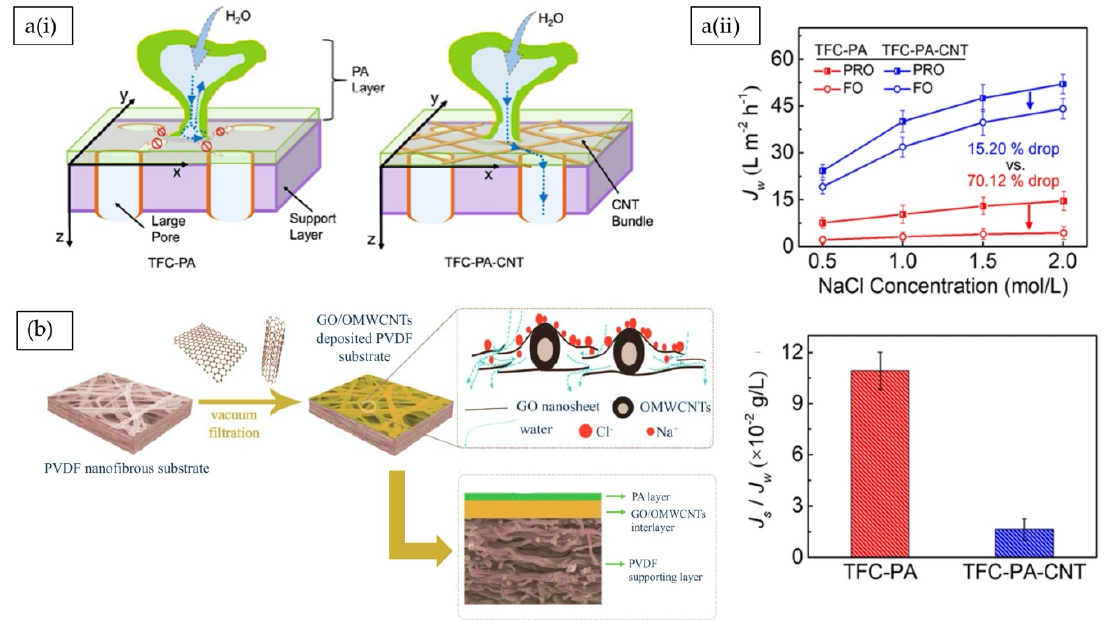
Figure 8. ( a ) Illustration of carbon nanotube (CNT) interlayer developing a channel for water transport on the PES substrate and the comparison of water flux [182]. ( b ) Fabrication route of graphene oxide (GO) / multiwalled CNT (MWCNT) interlayer on polyvinylidene fluoride (PVDF) nanofibrous substrates [184].